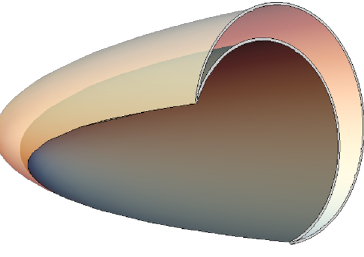
Figure 2 . Visualization of the glued Euclidean geometry. The ’ direction is suppressed and the partial circles are the Euclidean time circles (cid:28) and (cid:28) 0